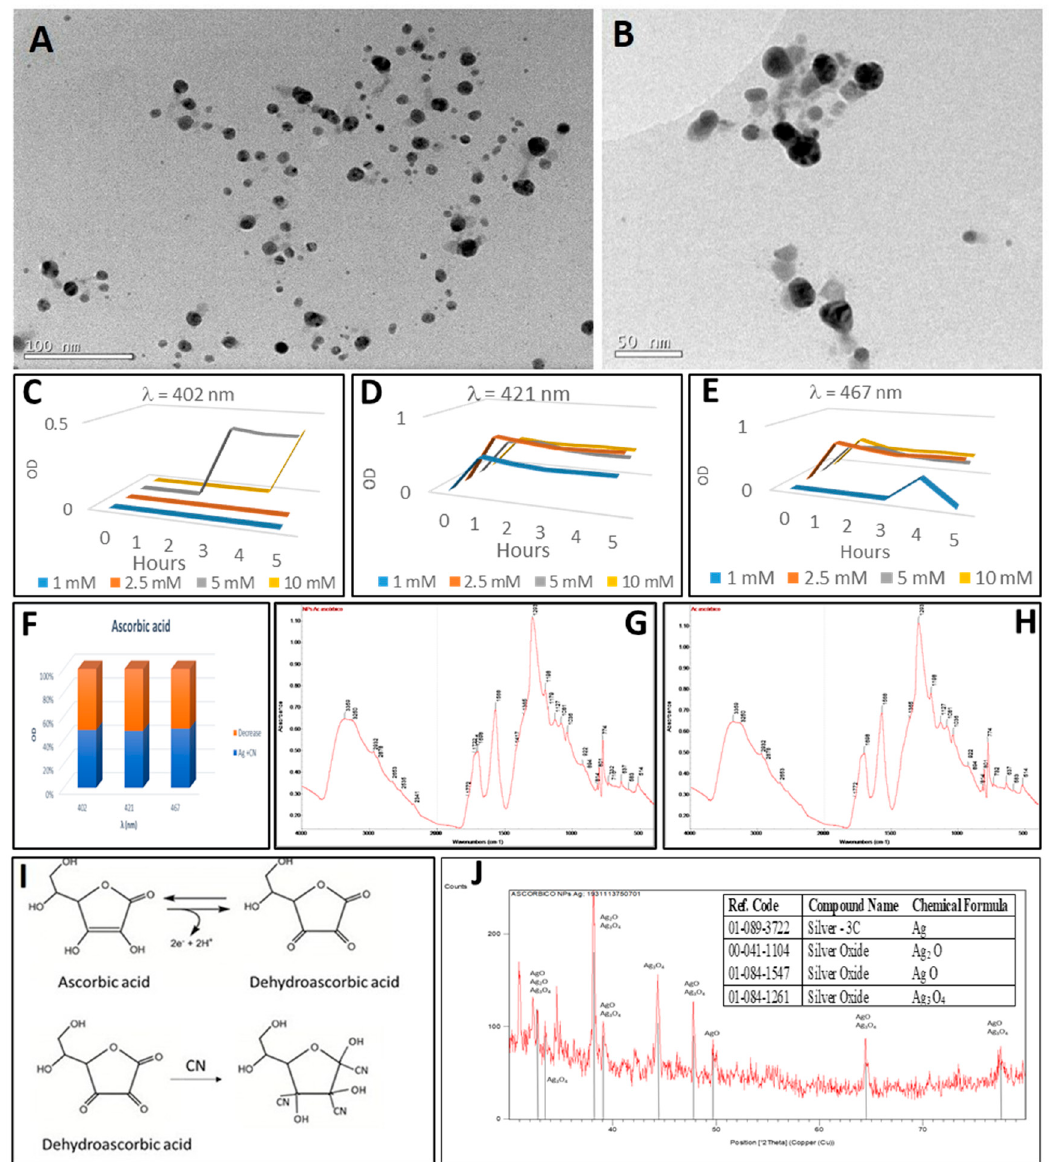
Figure 6. Analysis of silver nanoparticles synthesized with ascorbic acid. ( A ) TEM image of AgNPs. ( B ) image of AgNPs after treatment with cyanide. ( C – E ) Synthesis of silver nanoparticles by the reaction of different AgNO 3 concentrations with ascorbic acid for 5 h (in one-hour intervals). ( C ) maximum at wavelength 402 nm (20 nm-diameter nanoparticles). ( D ) maximum at wavelength 421 nm (50 nm-diameter nanoparticles). ( E ) maximum at wavelength 467 nm (80 nm-diameter nanoparticles). ( F ) decrease of the OD after cyanide addition to silver nanoparticles. ( G ) Fourier transform infrared (FTIR) spectrum of ascorbic acid-derived nanoparticles. ( H ) FTIR spectrum of ascorbic acid. ( I ) Redox reaction of ascorbic acid to dehydroascorbic acid and effect of cyanide addition. ( J ) FTIR Scheme 3. in the insert, the table with the identifications. Peaks identifying the presence of silver oxides have been indicated in the XRD